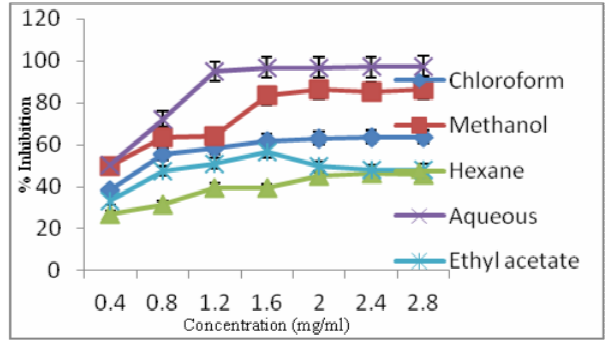
Fig. 1. Inhibitory effect of C. odorata fractions on the specific